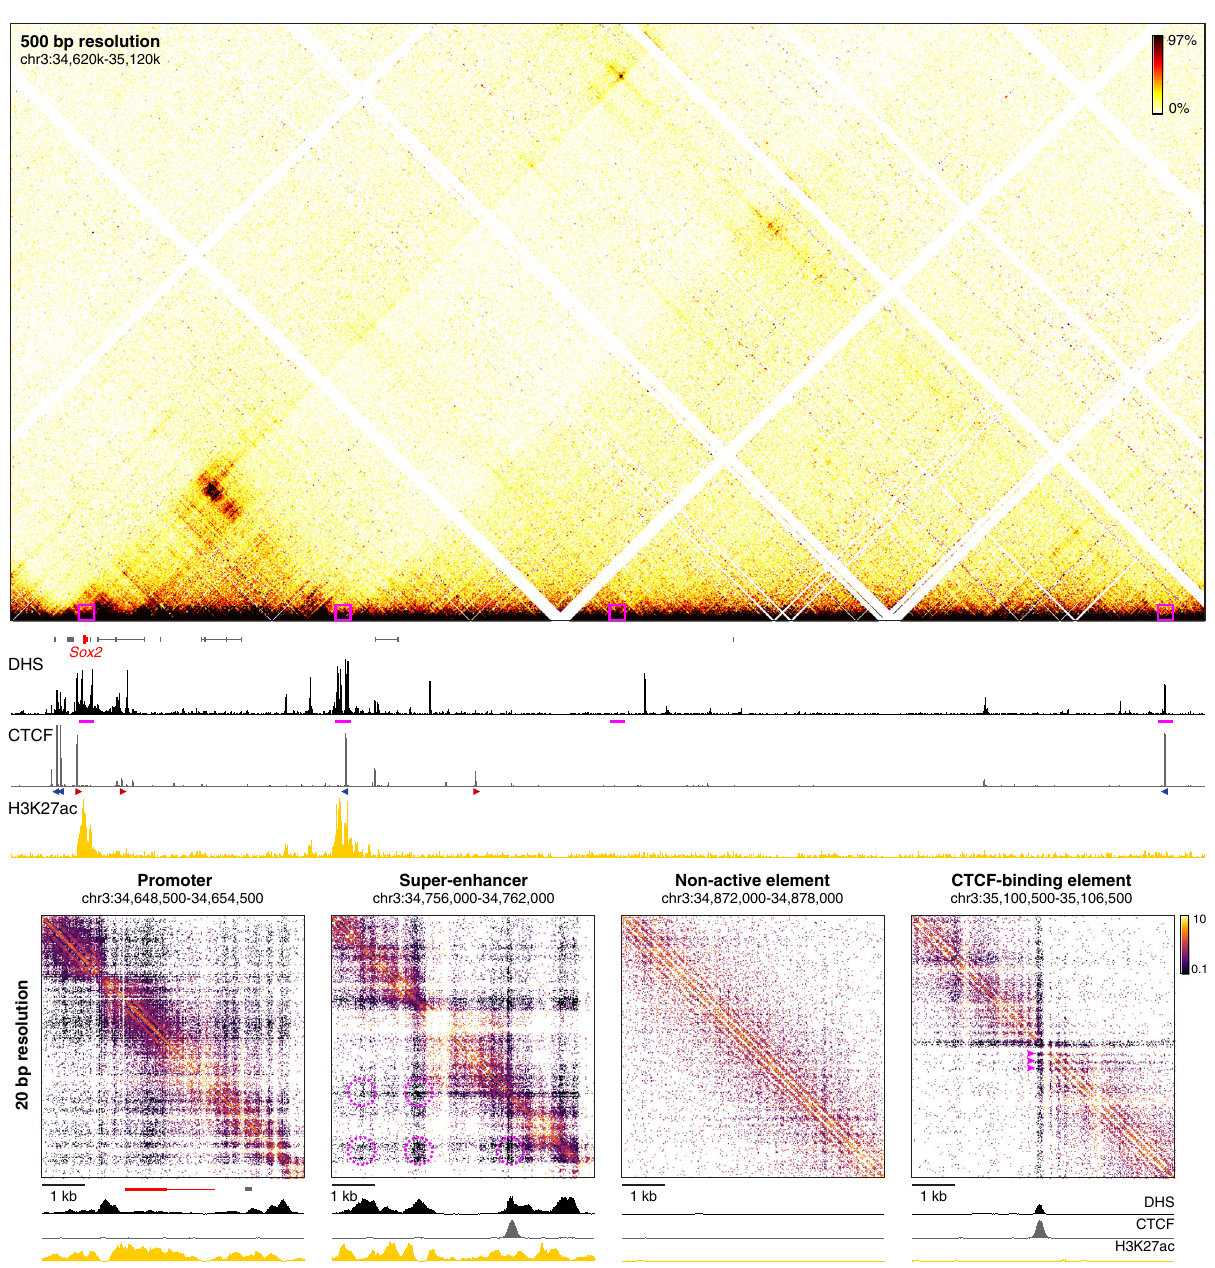
Fig. 2 High-resolution analysis of Tiled-MCC ligation junctions identi fi es micro-topologies of cis -regulatory elements in the Sox2 locus. The fi ne-scale contact matrices at the bottom show ligation junctions identi fi ed by Tiled-MCC in the Sox2 locus at 20 bp resolution. A large-scale contact matrix (500 bp resolution), gene annotation ( Sox2 in red, coding genes in black, non-coding genes in gray), DNase hypersensitive sites (DHS), and ChIP-seq data for CTCF and H3K27ac for the extended Sox2 locus are shown in the top panels. The 6 kb regions covered in the fi ne-scale contact matrices are highlighted with magenta boxes in the contact matrix at the top and with magenta bars below the top DHS pro fi le, and show a promoter, super-enhancer, non-active element, and CTCF-binding element. The axes of the top and bottom DHS and ChIP-seq pro fi les for CTCF and H3K27ac are fi xed and have the following ranges: DHS = 0 – 5; CTCF = 0 – 1500; H3K27ac = 0 – 50. The orientations of CTCF motifs at prominent CTCF-binding sites are indicated by arrowheads (forward orientation in red; reverse orientation in blue). The magenta highlights in the contact matrix covering the super-enhancer indicate enriched interactions between DHSs; the magenta highlights in the contact matrix covering the CTCF-binding element indicate phased for the identi fi cation of the precise locations of chromatin of the precise locations of the junctions, they are dif fi cult to interactions, which increases the signal-to-noise ratio of the interpret quantitatively and not straightforward to normalize. Tiled-MCC data and allows for local analysis at extremely high Traditional ICE-normalized 52 contact matrices at very high resolution (20 bp) uncover the same features without artifacts resolution. The identi fi ed junctions can be visualized in density (Supplementary Fig. 6). These matrices allow for the analysis of plots, in which their exact locations are plotted and the density of local chromatin structures with unprecedented resolution and these plotted points is indicated with a color code (Supplementary reveal characteristic micro-topologies across the genome (Fig. 2). Fig. 6). Although these density plots allow for direct visualization